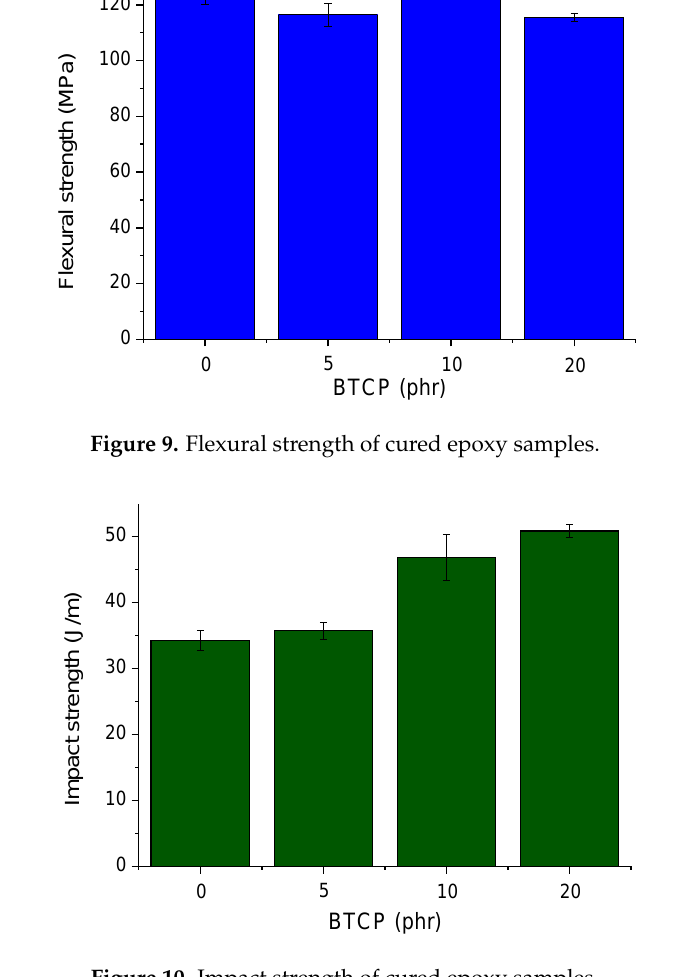
Figure 10. Impact strength of cured epoxy samples.